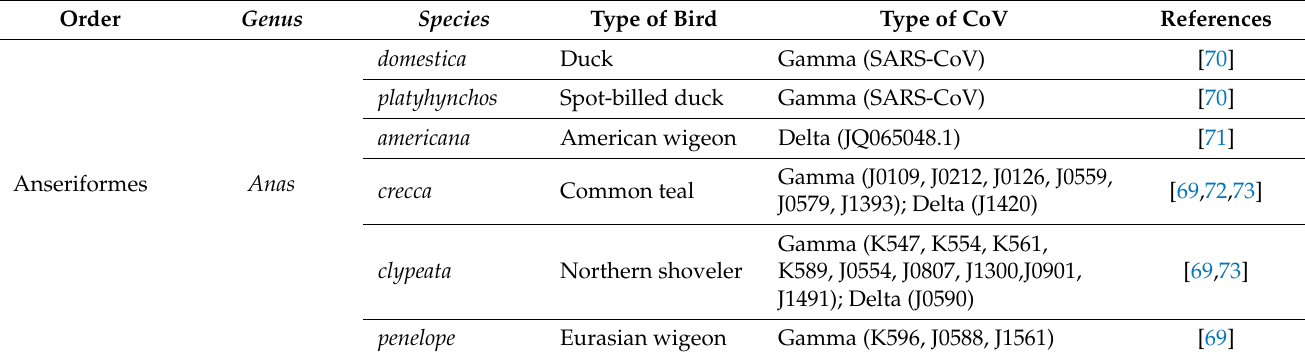
Table 2. Coronavirus found in waterfowl of the order